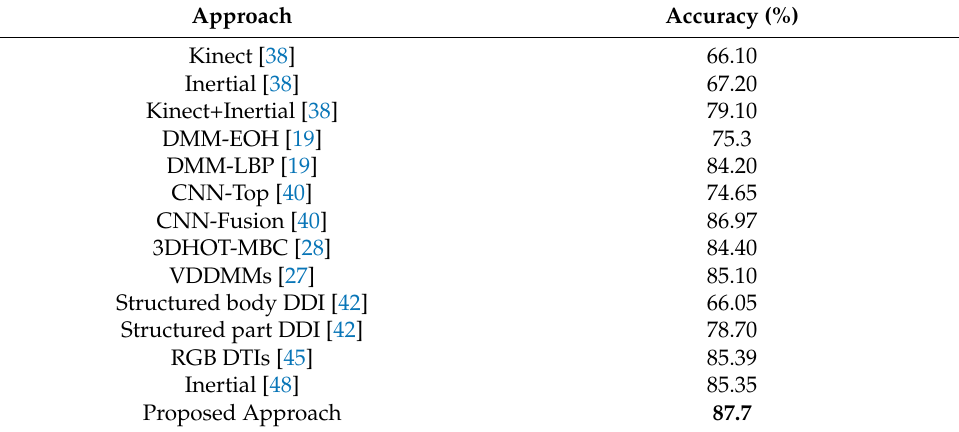
Table 5. Comparison of action recognition accuracy (%) with state-of-the-art frameworks on the UTD-MHAD dataset.